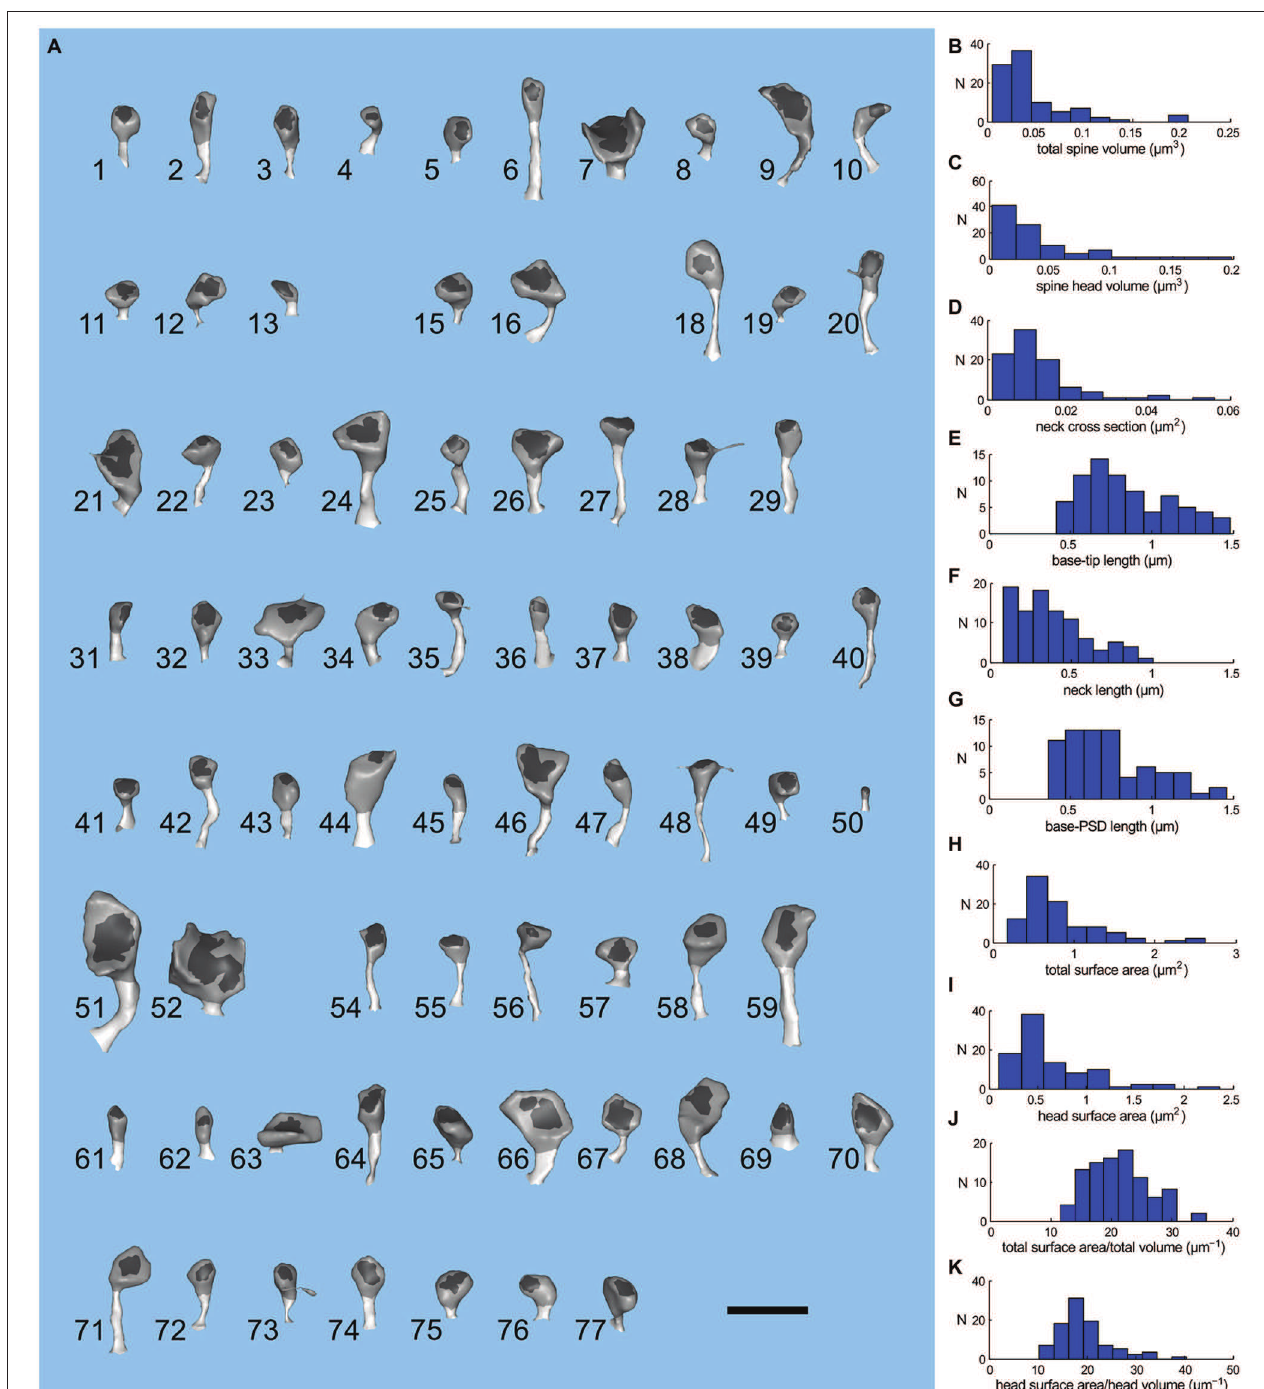
FIGURE 4 | Geometry of spines of the large apical dendrite. (A) Visual index of the spines of the large apical dendrite. Spines have been oriented to view both head and neck. The PSD region is dark gray; spine head, medium gray; and spine neck, light gray. The spines are numbered 1–77 and have not been sorted. Five spines (numbers 14, 17, 30, 53, and 60) were omitted from the simulations because they were clipped by the boundary of the reconstructed volume. Thus, the apical dendritic segment contains 72 intact spines. The scale bar is 1 µ m. (B–K) Distribution of geometric parameters of the spines. (B) Total spine volume. (C) Spine head volume. The average spine head volume in the sample was 0.03 µ m 3 . (D) Spine neck cross sectional area. (E) Base-tip length. The average spine length from the base of the spine to the apex of the head was 0.85 µ m. (F) Spine neck length. (G) Base to PSD length. (H ) Total surface area. (I ) Head surface area. (J) Ratio of total spine surface area to total spine volume. (K) Ratio of head surface area to head volume.